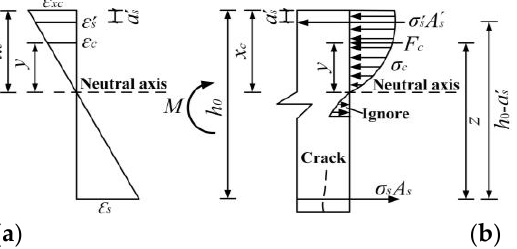
Figure 16. Stress and strain diagrams of the anti-slide pile in normal section Stage Ⅱ . ( a ) Distribution of average strain; ( b ) distribution of normal stress.